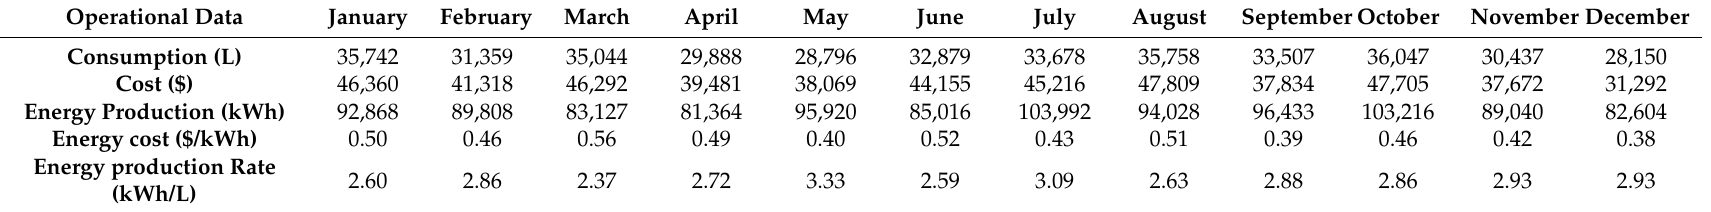
Table 1. Monthly operational data, year 2014.